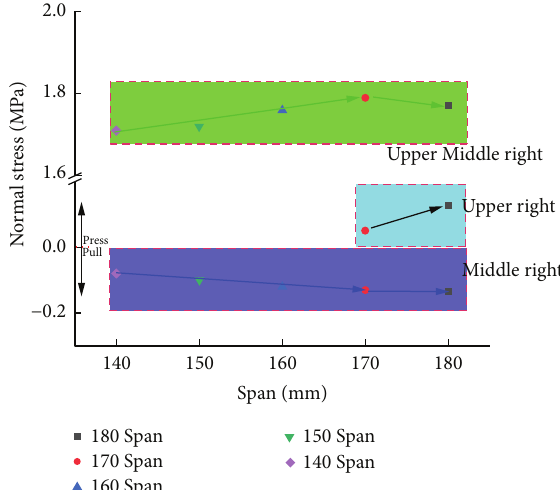
Figure 6: Peak stress at feature points with different